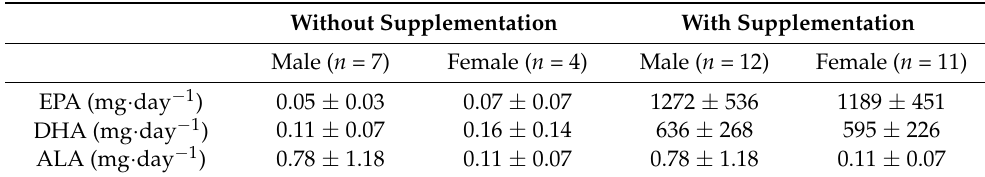
Table 4. Dietary fatty acid intake with and without